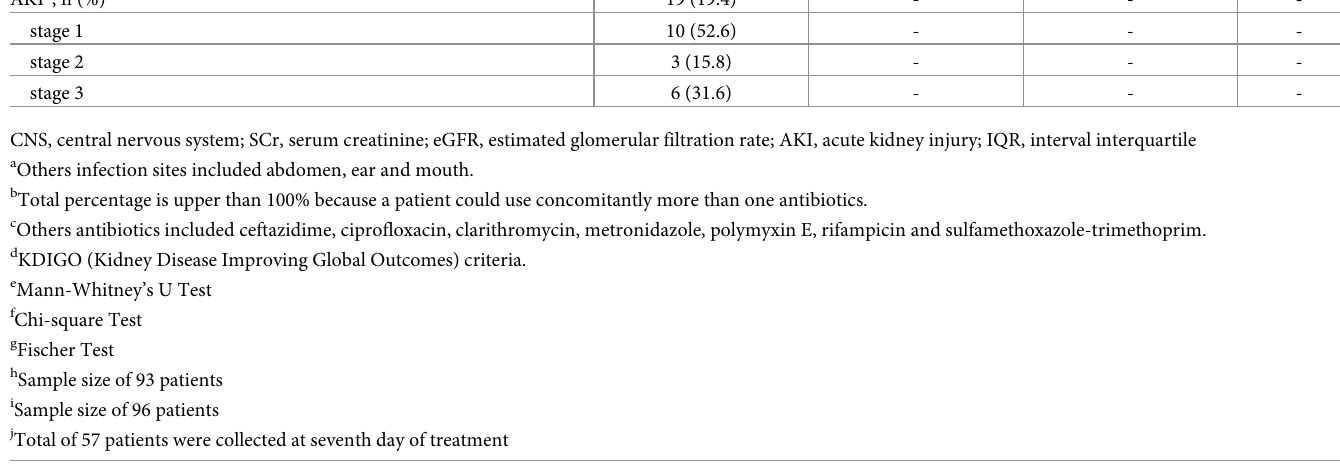
2.4g (n = 4/98) per day. Among patients receiving 2g/day of vancomycin, 37 (43.5%)